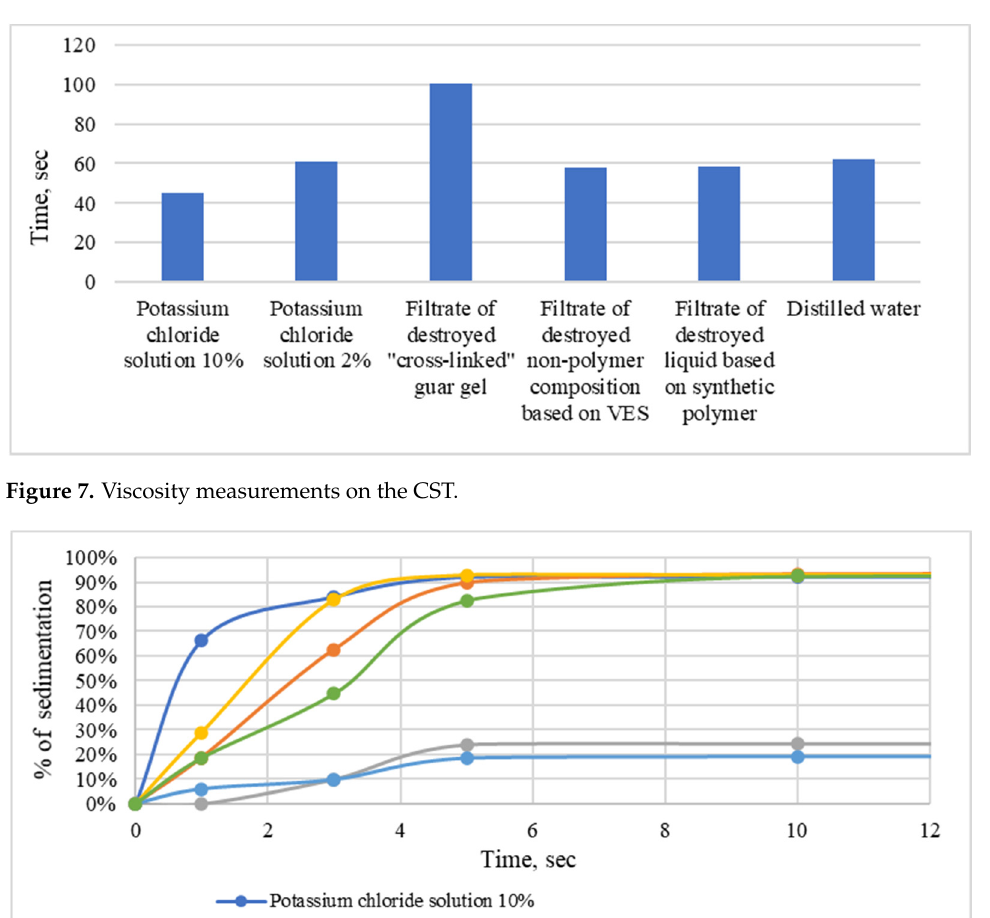
Figure 6. Dependence of the viscosity on the shear rate of destroyed samples: “crosslinked” guar gel ( a ); non-polymer composition based on VES ( b ); liquid based on synthetic polymers ( c ). 1 Possi- ble experimental error.